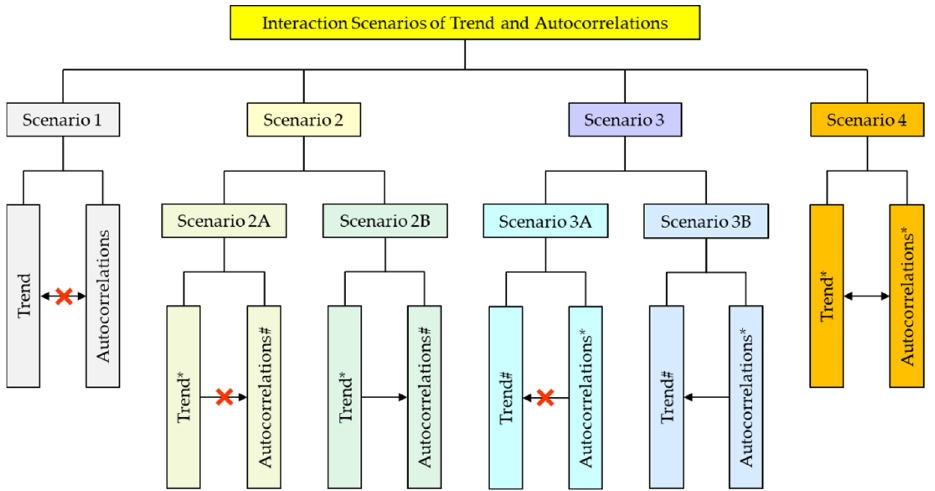
Figure 1. Interaction scenarios of trends and autocorrelations in HCTS. (Note: the arrows represent the action directions; ‘ ✖ ’ indicates no interaction between trend and autocorrelations; ‘*’ denotes a significant trend or significant autocorrelations; and ‘#’ indicates a significant pseudo trend or sig- nificant pseudo autocorrelations).